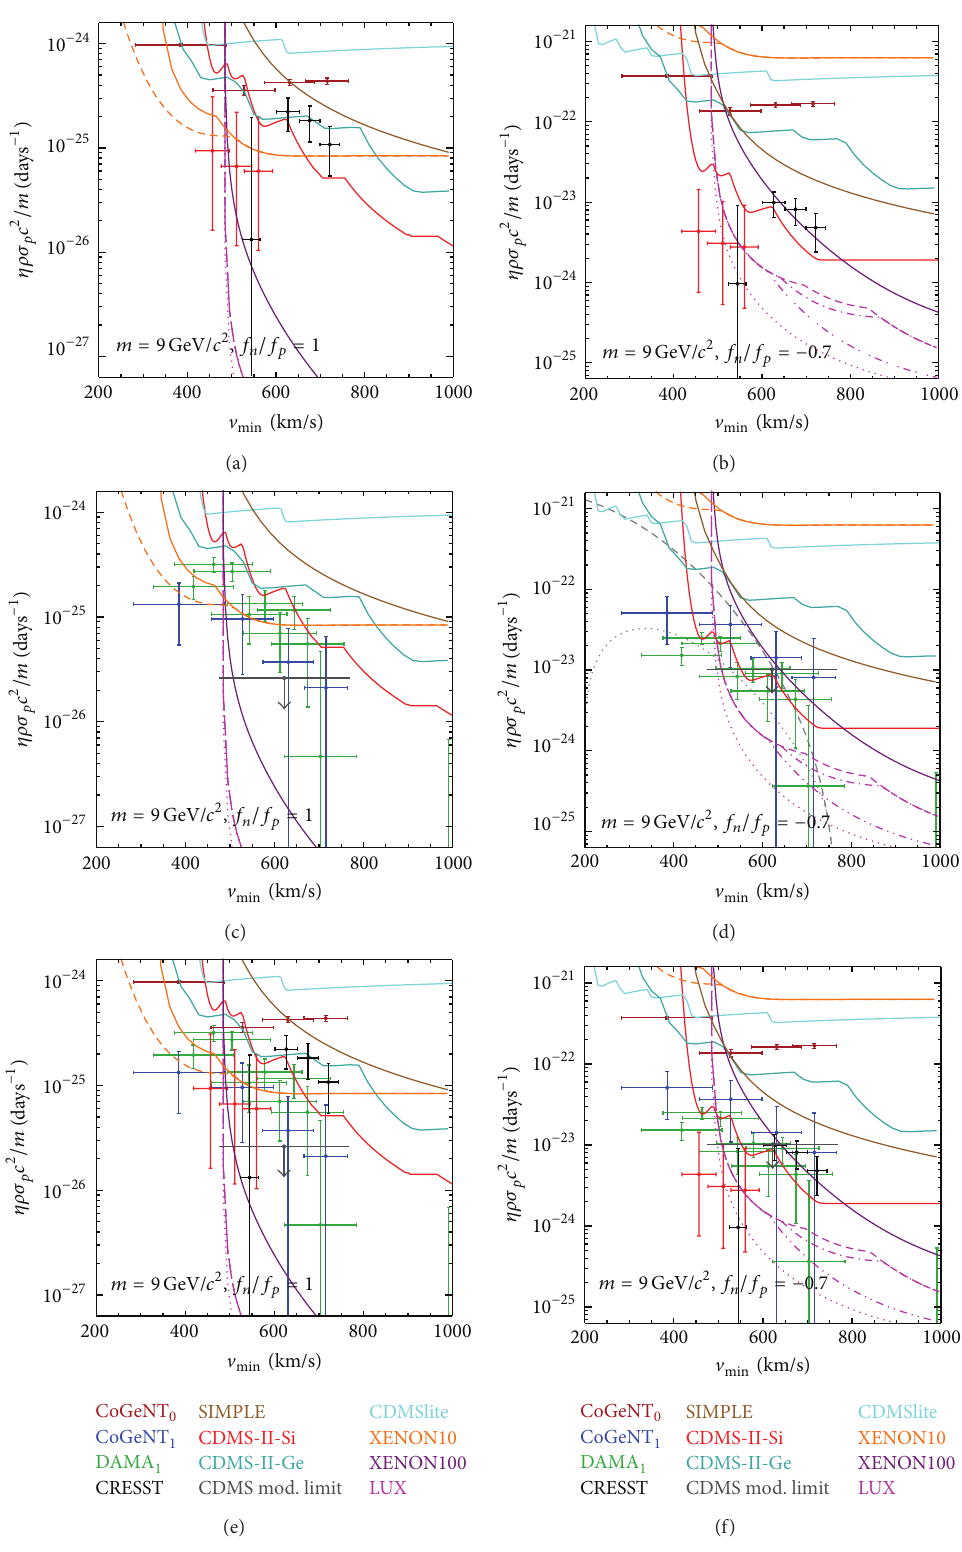
Figure 2: Same as Figure 1 but for a DM mass 𝑚 = 9 GeV/ 𝑐 2 . The dashed gray lines in the middle right panel show the expected ̃𝜂 0 𝑐 2 (upper line) and ̃𝜂 1 𝑐 2 (lower line) for a WIMP-proton cross section 𝜎 𝑝 = 2 × 10 −38 cm 2 in the SHM (see